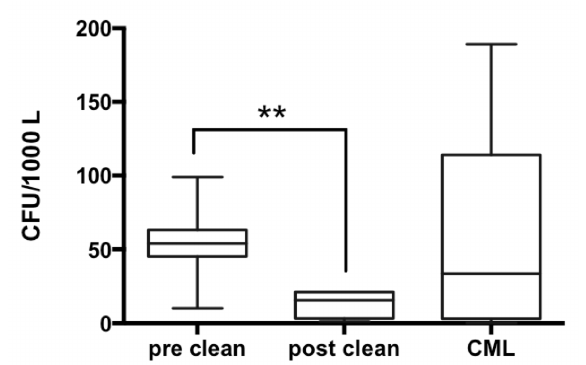
Figure 2. Airborne bacterial count close to acoustic flow cytometer sample introduction port during use, before (pre clean) and after research laboratory cleaning (post clean), compared with samples from the clinical microbiology laboratory (CML) where no interventional cleaning was undertaken. Pre clean research laboratory and post-clean median counts in close proximity to flow cytometer sample introduction port = 54 and 15.5 CFU/ 1000 L, U = 2.5, **p =